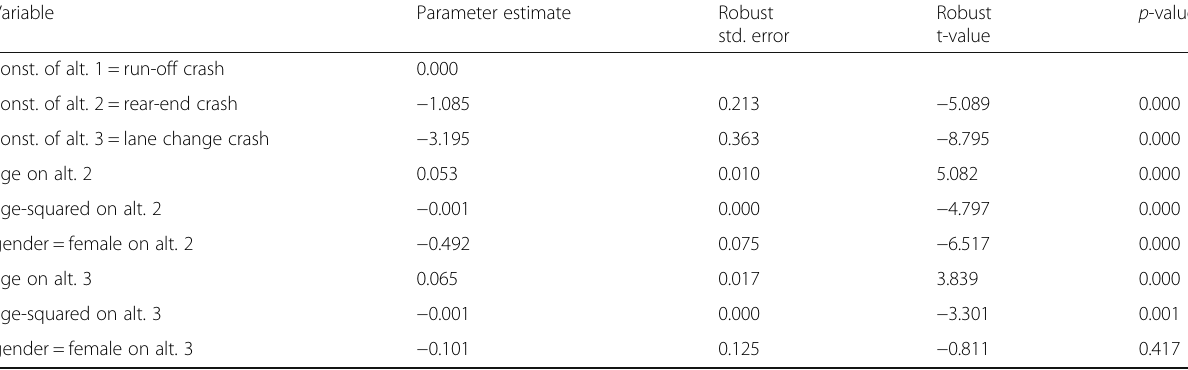
Table 5 Multinomial logit model of three different crash types (reference type = run-off crash); sample = mainly responsible car drivers involved in a motorway crash; predictors = age and gender (reference gender = male) Variable Parameter estimate